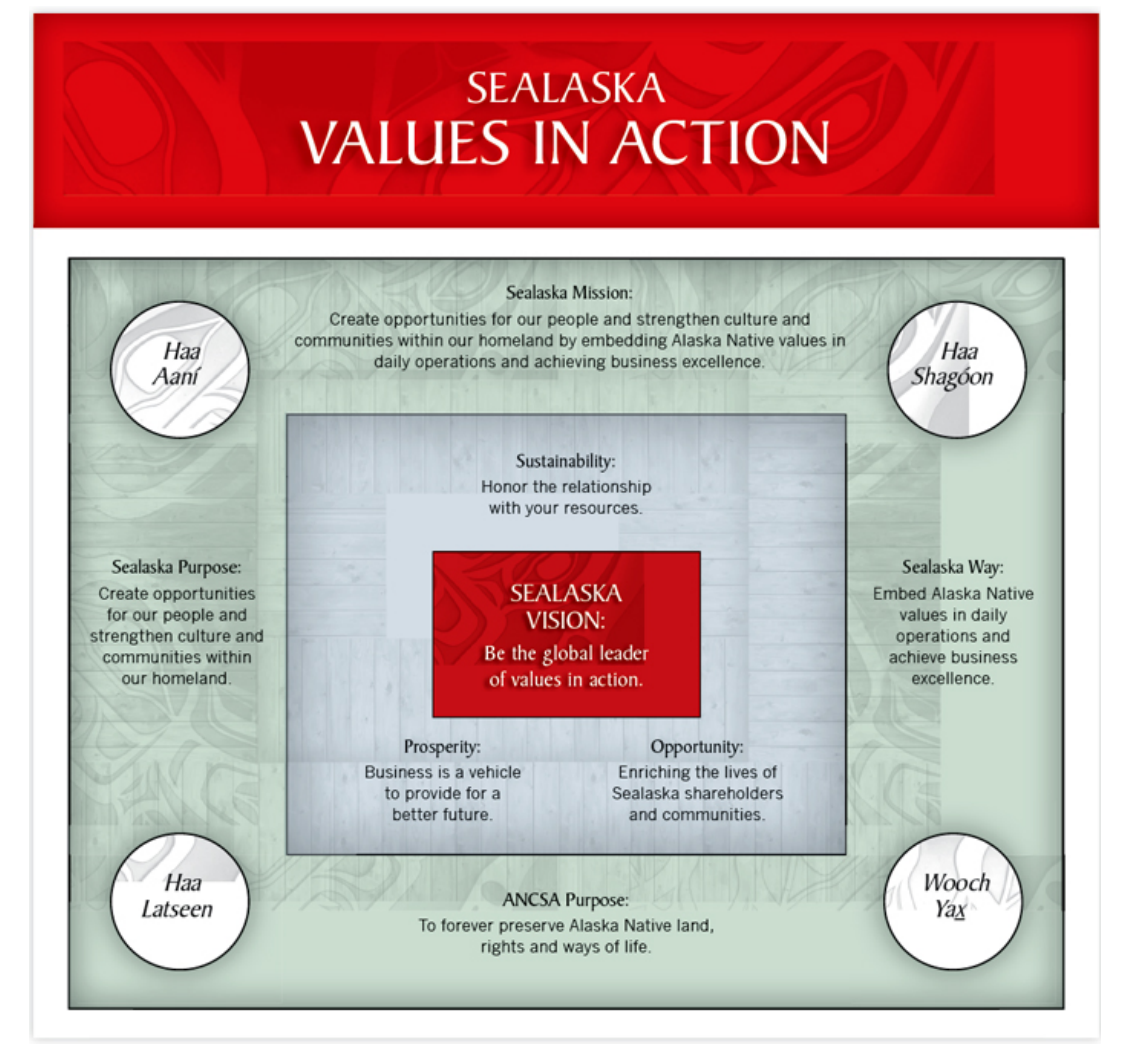
Fig. 1 . Sealaska Values in Action, a cultural model of sustainability and well-being, evolved partly as a result of the failure of first generation industrial logging on the limited corporation land base to produce sustainable benefits in Tlingit and Haida rural communities. Courtesy of Sealaska